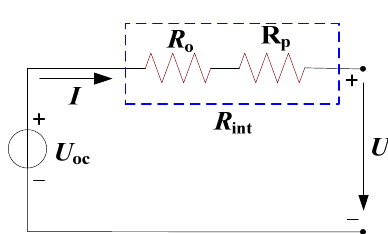
Figure 7. The Rint battery